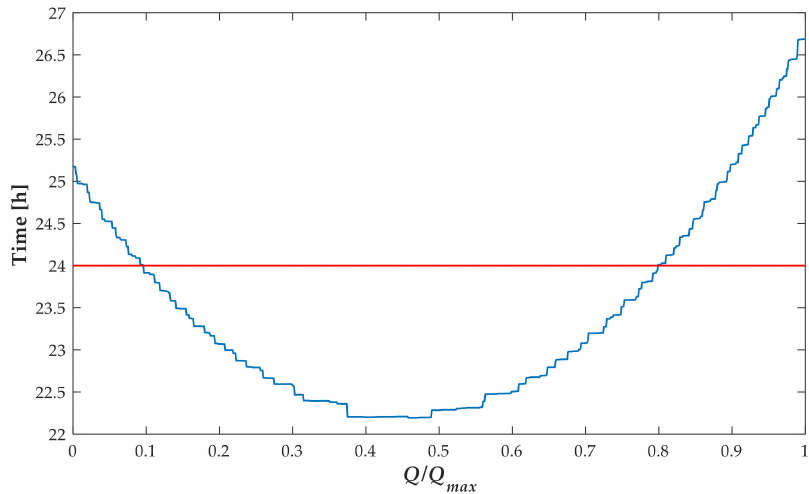
Figure 12. Change in daily transformer aging in function of reactive power factor of the EVCS.